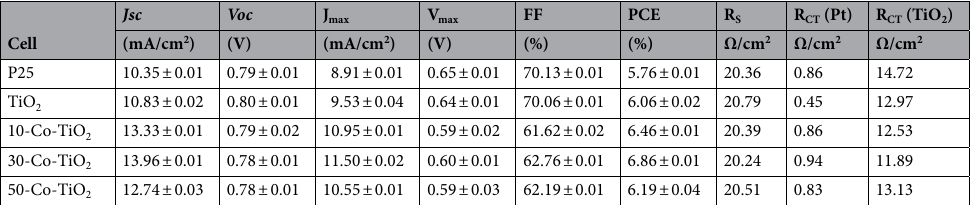
Table 1. A comparative DSSC photovoltaic performance data determined by photocurrent density–voltage ( J–V ) and EIS characteristic analysis of different photoanodes.